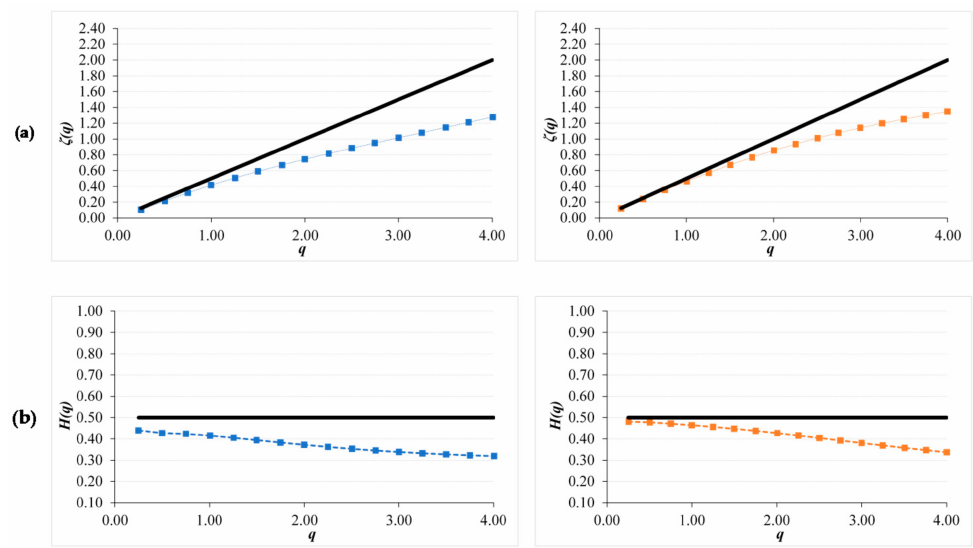
Figure 9. Generalized Structure Function plots for NDVI residual series of SOM5 (left column in blue) and SOM15 (right column in red) for: ( a ) ζ ( q ) curve and ( b ) Generalized Hurst exponent H( q ), continuous line correspond to non-correlated noise with Hurst value of 0.5.